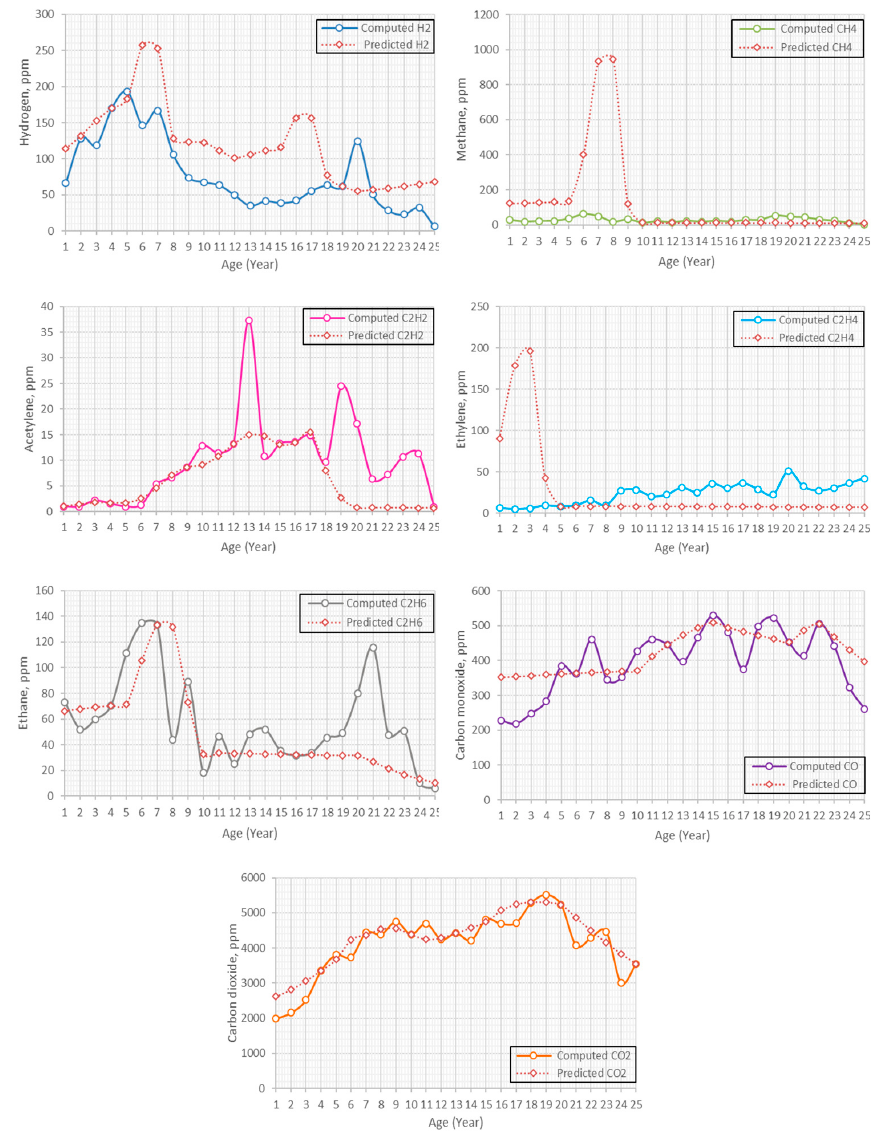
Figure 4. Comparison between computed and predicted hydrogen, methane, acetylene, ethylene, ethane, carbon monoxide and carbon dioxide.